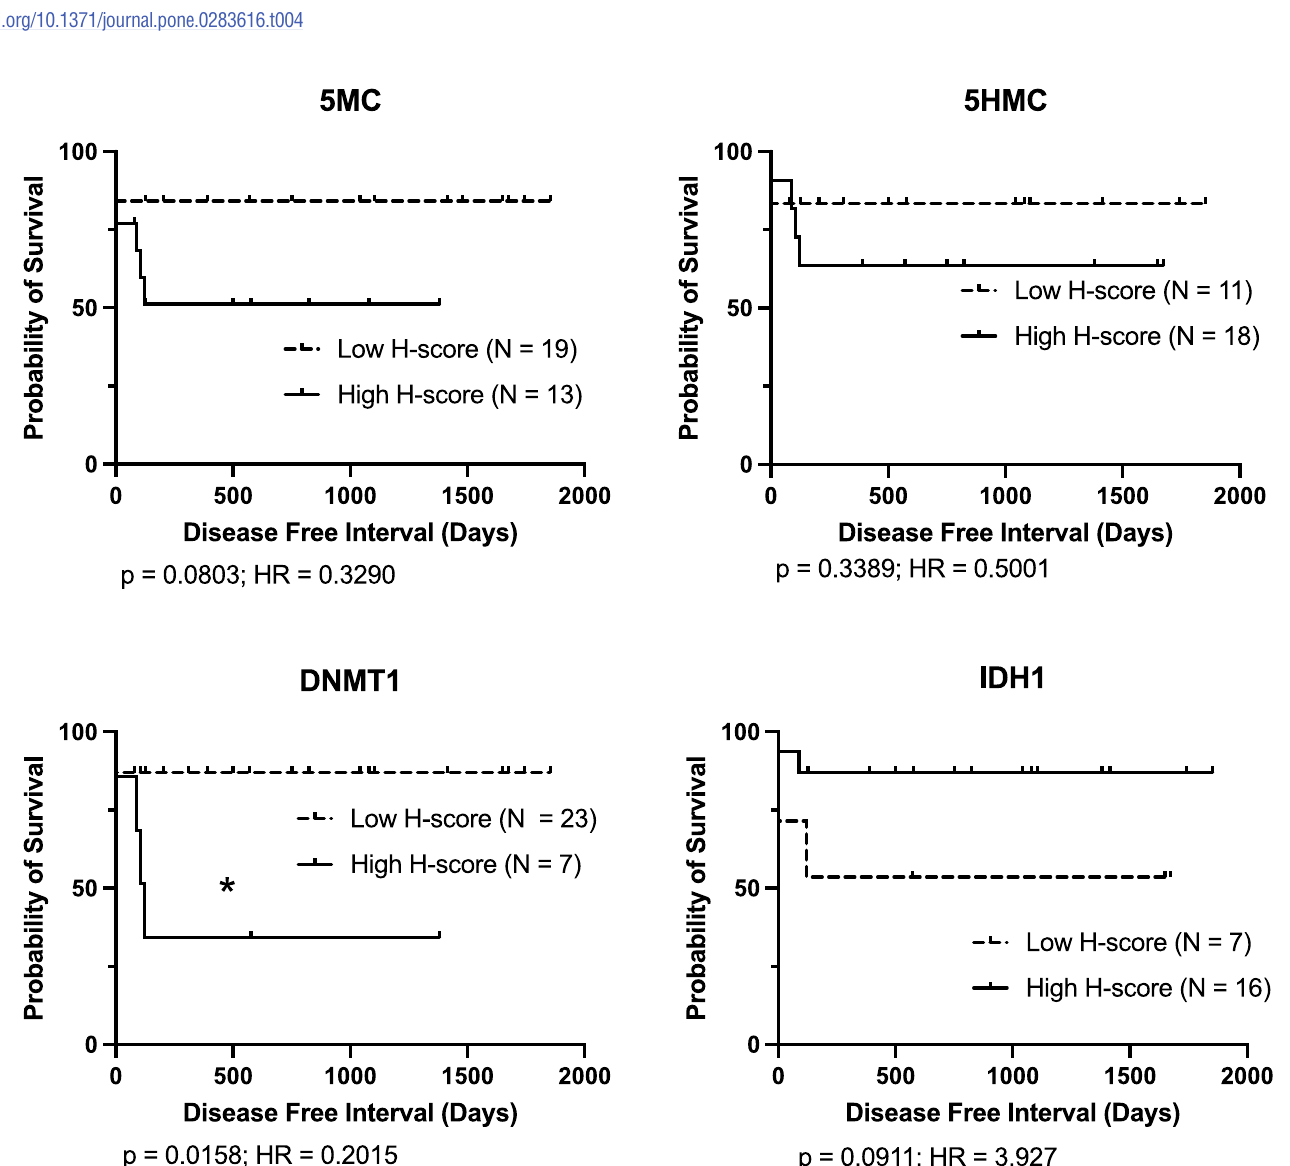
Fig 5. Kaplan-Meier survival curves for DFI for Patnaik’s grading system grade II cases. Logrank analysis indicates comparisons showing significant differences (p < 0.05). Cases lost to follow-up, still healthy at last follow-up, or that died of causes unrelated to MCT disease are indicated by upward ticks on the curves, and were right-censored for